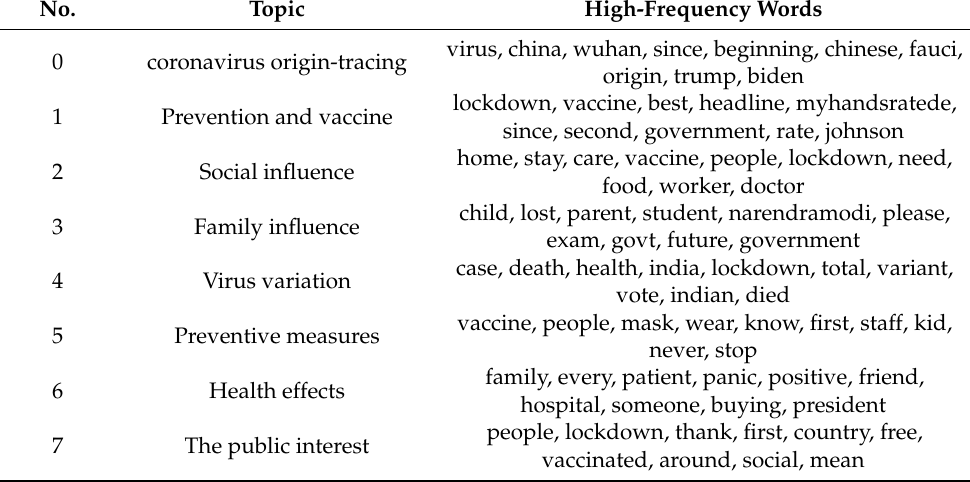
Table 3. Eight topics of LDA model.